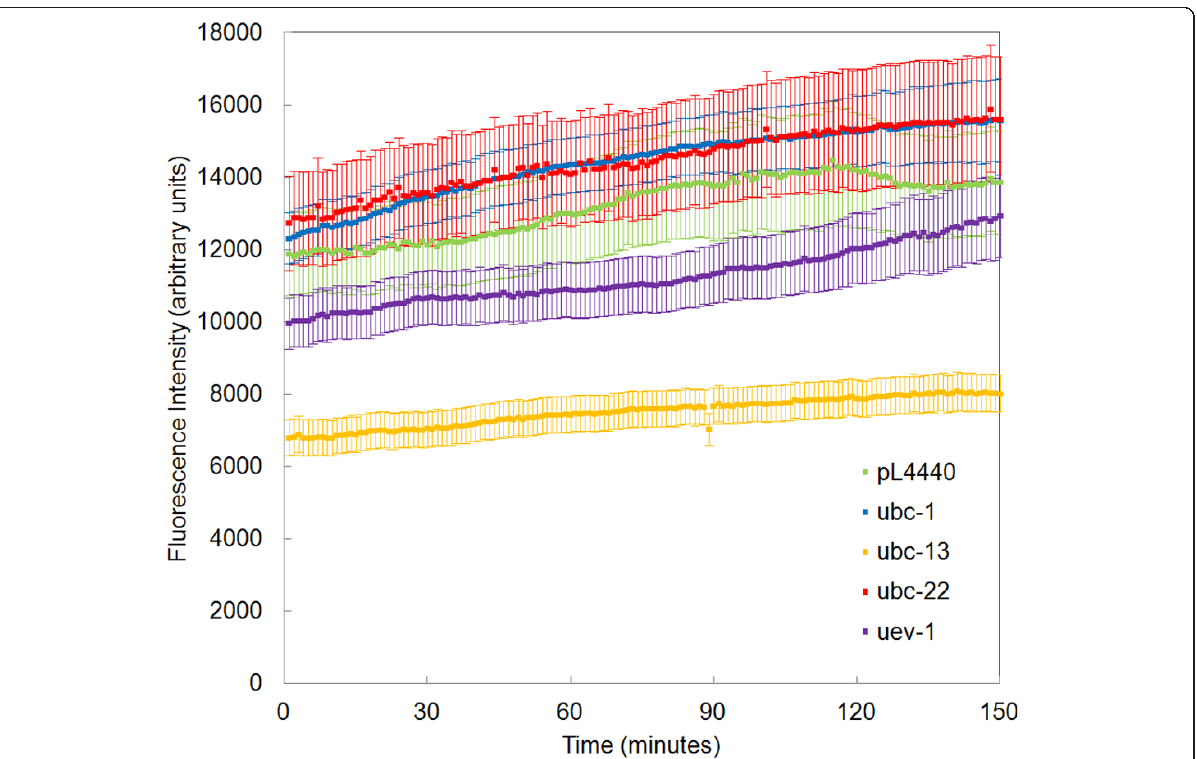
Figure 3 RNAi knockdown of UBCs alters the secondary growth of aggregates . C. elegans expressing a Q82::GFP transgene were fed bacterial clones expressing dsRNA against the indicated genes or the empty pL4440 vector as a control, beginning at the L2 stage. The progeny of these worms, belonging to the same population as the worms analyzed in Figure 2, were imaged using a microscope with a 10X objective lens at a rate of 1 frame per minute. Aggregates that had formed prior to mounting on the slide were located using the automatic object tracking feature of Image Pro Plus 6.1, which uses an intensity threshold to define the borders of the aggregates. The sum pixel intensity within each automatically defined region was measured over time, omitting objects that formed during the observation period. The Y axis represents the mean pixel intensity for all aggregates, plotted by gene. At least 50 aggregates were analyzed for each RNAi treatment. See Table 2 for calculation of aggregation rates.